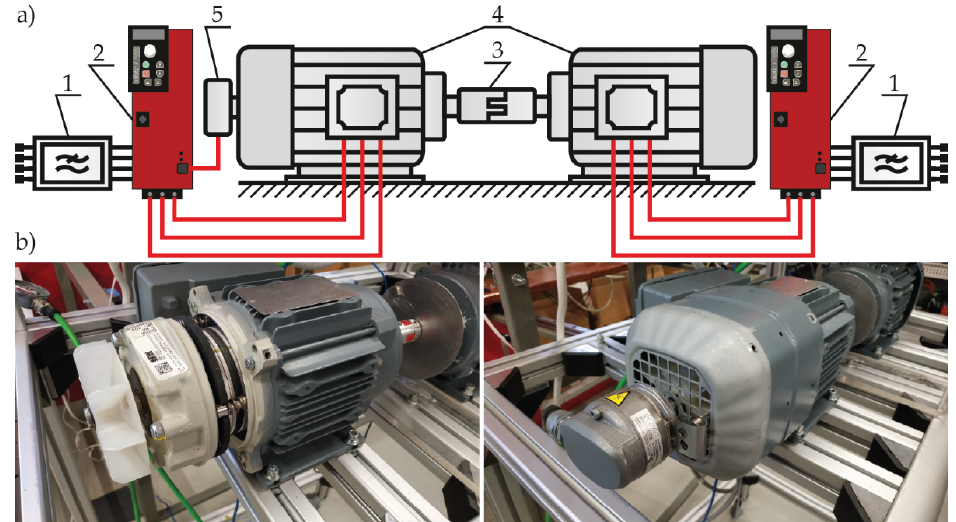
Figure 1. View of: ( a ) a configuration diagram of the test stand, ( b ) the laboratory stand, where: 1—power supply, 2—frequency converter, 3—single-piece clutch, 4—electric motor, 5—encoder. The motor parameters are listed in Table 2. Table 2. Parameters of the tested electric motor (DRS71S4BE05/FI/TF/ES7S). Parameter